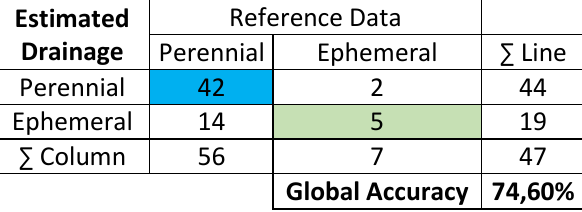
Table 6 – Accuracy Assessment of Estimated Drainage in Joinville.